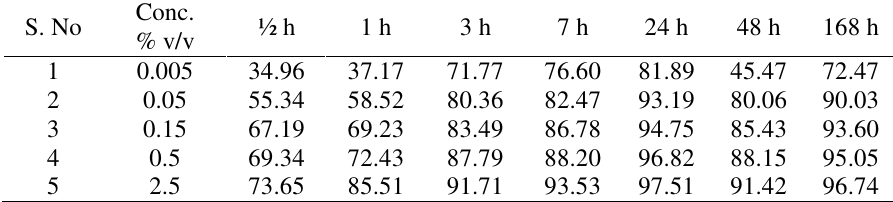
Table 2. Inhibition efficiency of MS in 1 M HCl in the presence of CAL at 303